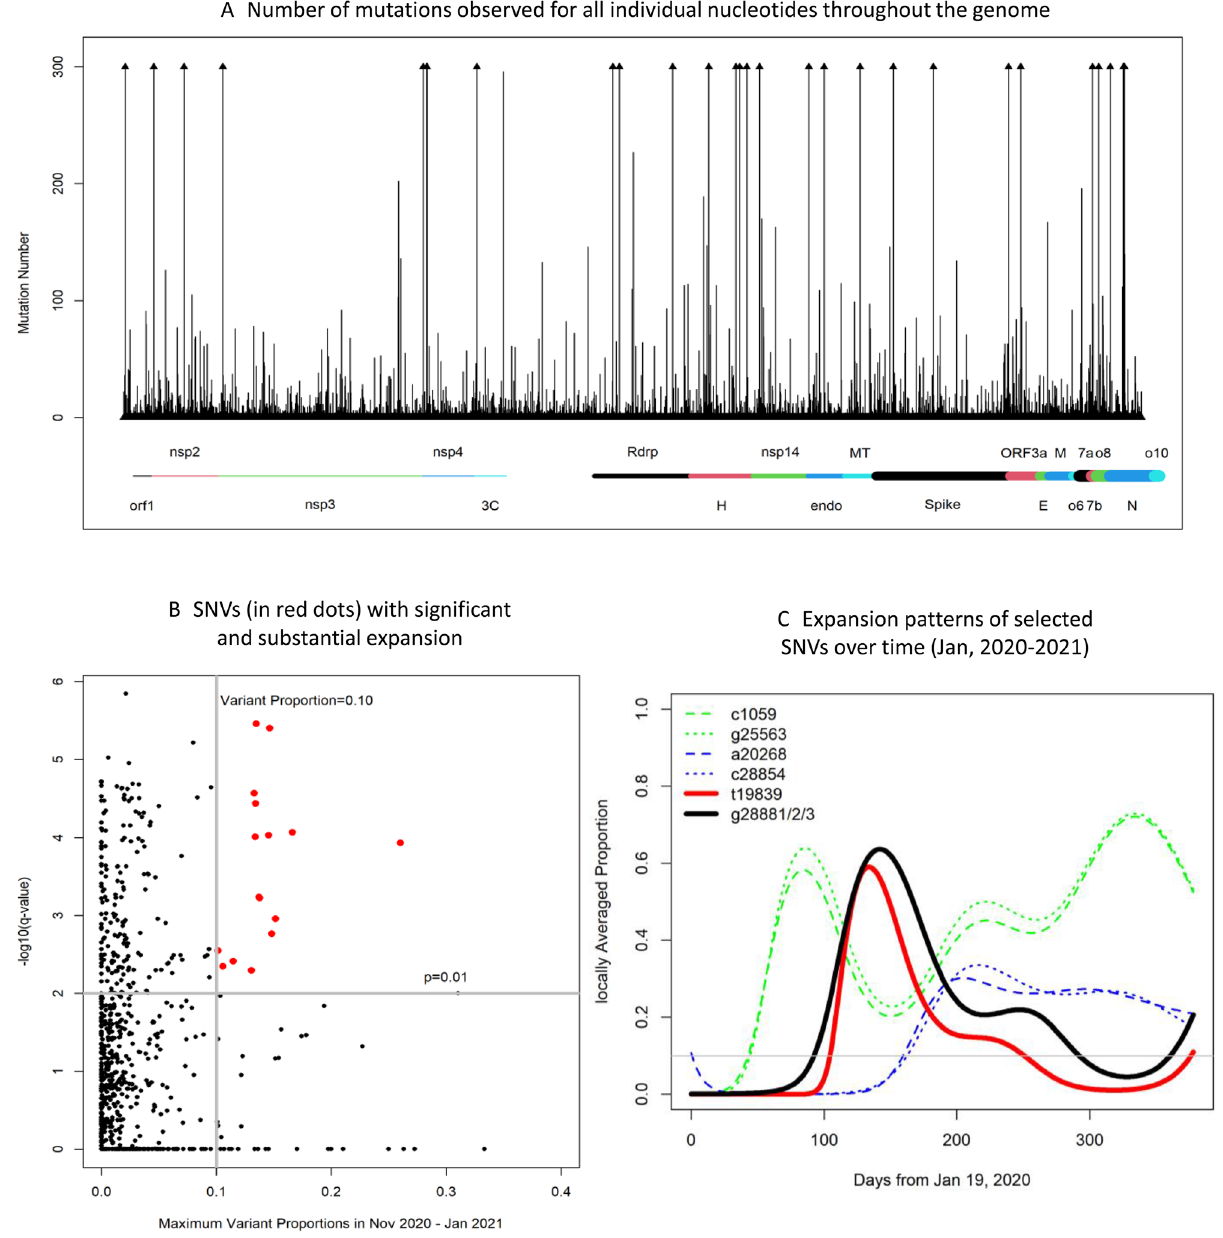
Figure 1. Results from analyzing 7137 viral genomes sequenced by laboratories in Washington state and deposited to GISAID. ( A ) Results from counting mutational numbers per nucleotide throughout the viral genome. Upper arrow indicates observed counts greater than 300. The viral genome is annotated with gene designations immediately below. ( B ) Computed q-values and maximum values of variant proportions in November 2020, December 2020, and January 2021, obtained from fitting generalized linear models to all individual SNVs. SNVs exceeding established threshold q-value and maximum proportions are highlighted in red (upper right corner). ( C ) Eight selected SNVs with significant and substantial temporalities are mapped using their locally averaged variant proportions over time from fitted generalized linear models (color key upper